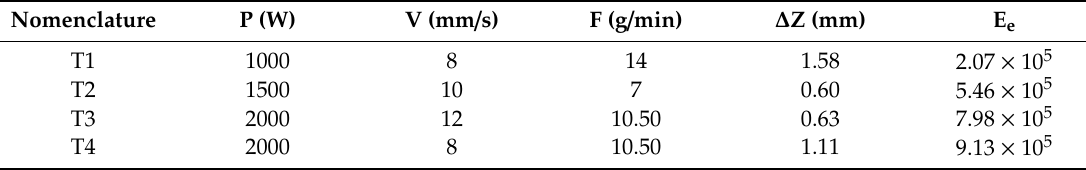
Table 3. The specific laser melting deposition (LMD) process parameters of Ti6Al4V bulks and their E e value with a beam diameter of 3